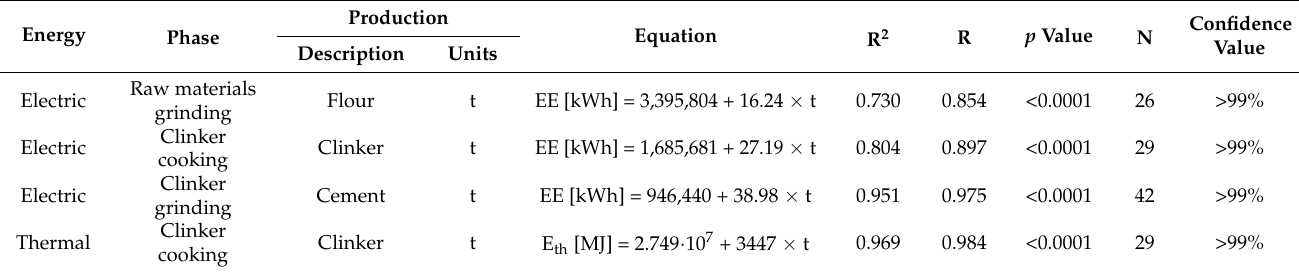
Figure 21. NACE 23.51: linear regression of thermal consumption of the clinker cooking phase. Table 4. NACE 23.51: Statistical parameters of linear regression: phase